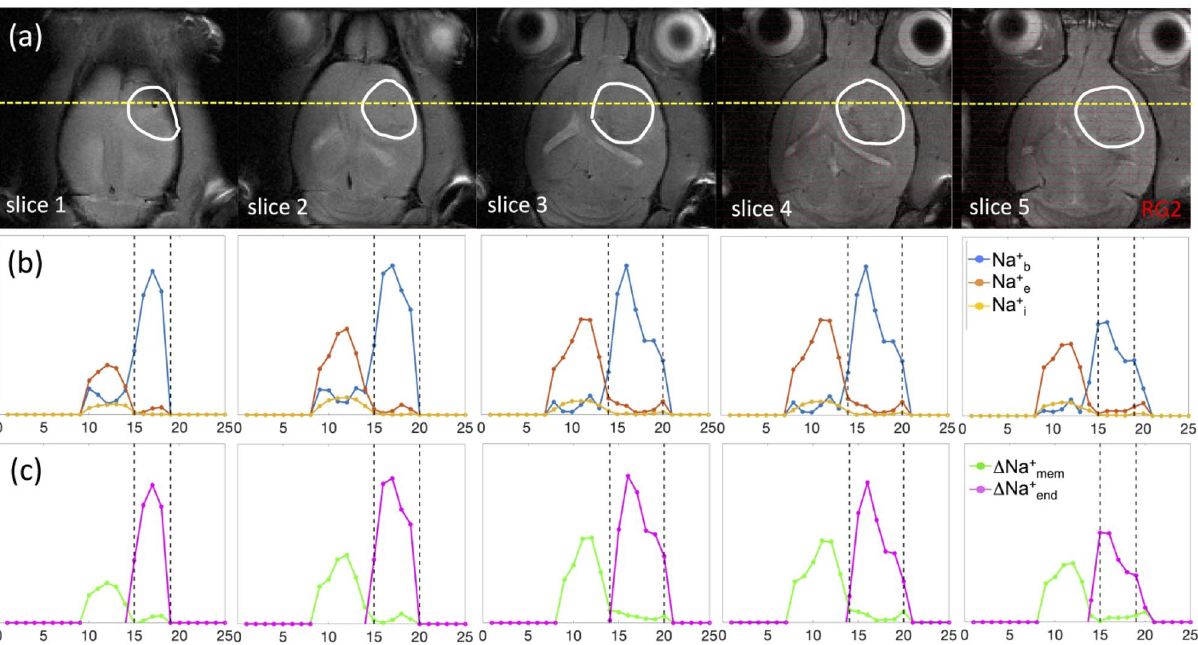
Figure 5. Coronal projections of compartmentalized 23 Na signals (Na + b , Na + e , Na + i ) as well as transendothelial (ΔNa + end ) and transmembrane (ΔNa + mem ) gradients in an RG2 tumor. ( a ) Axial 1 H-MRI indicating the tumor (white outline) across slices (same as Fig. 4), where the yellow line indicates the position for a coronal projection. ( b ) Spatially varying 23 Na signals for Na + b , Na + e , and Na + i are shown with blue, orange, and yellow lines, respectively, where the vertical black lines indicate the tumor boundary. The Na + b signal (blue) is clearly elevated in the tumor, and most elevated in slices 1–4 (or superficially). Behavior of Na + b signal (blue) is inversely related to Na + e signal (orange), which is high outside the tumor and weaker inside the tumor. While intratumoral Na + b signal (blue) is high in slices 1–4, the peritumoral Na + e signal (orange) is highest in slices 3–4. Comparatively, the Na + i signal (yellow) does not vary significantly across slices, but slightly lower inside the tumor than outside the tumor. ( c ) Behaviors of ∆Na + mem (green) and ∆Na + end (magenta) signals closely mimic patterns of Na + e and Na + b signals, respectively, indicating that each of those Na + compartments is the primary driver of the respective Na + gradient. See Figure S5 for a similar example for a U87